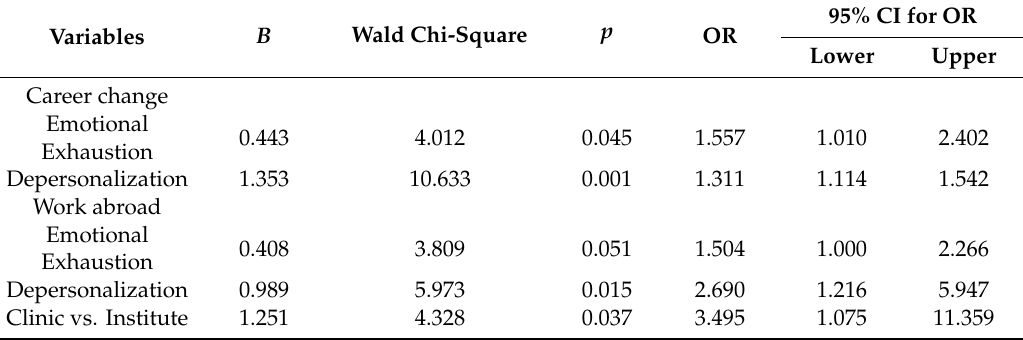
Table 5. Multivariate logistic regression models with career change and work abroad as dependent